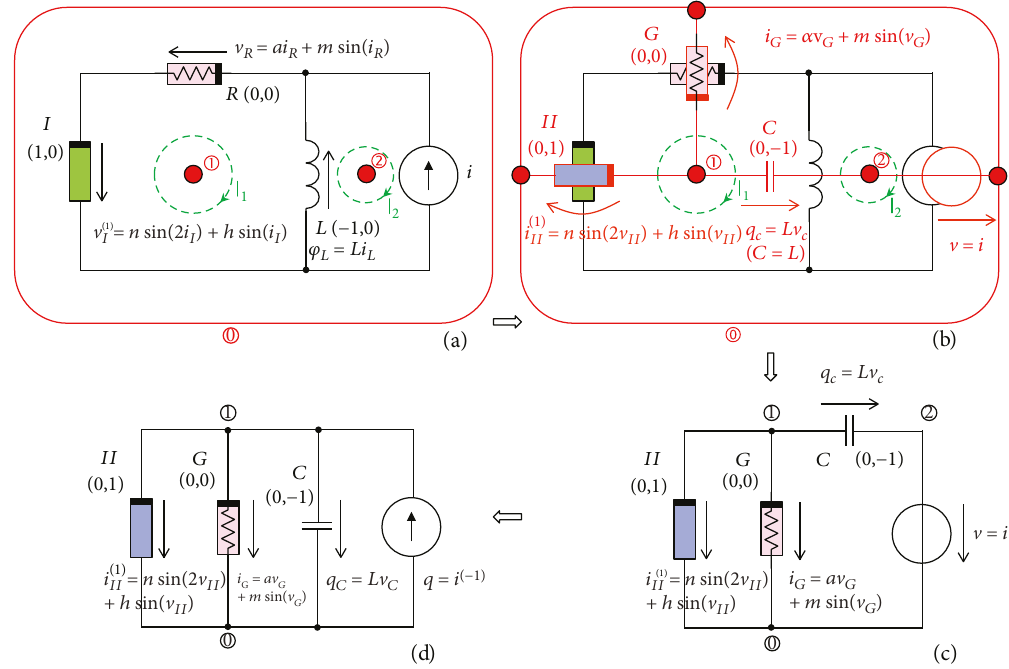
Figure 4: (a) Original circuit containing a nonlinear resistor R , a linear inductor L , a nonlinear inerter I (see [30] for details), and a current source i . The nodes ① and ② are added within the meshes (loops) l circuit. (b) Adding circuit elements which are duals of the elements from Figure 4(a). (c) Final dual circuit. (d) Equivalent circuit after the Thévenin transformation of the linear C-v subcircuit; a , m , n , and h are speci fi c parameters of nonlinear